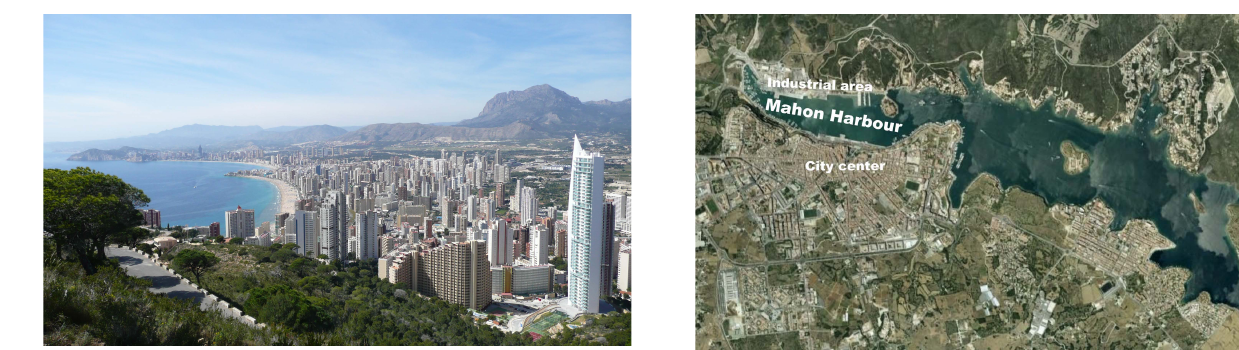
Fig. 11. Satellite image of the Mah´on port, main commercial port and tourism center of